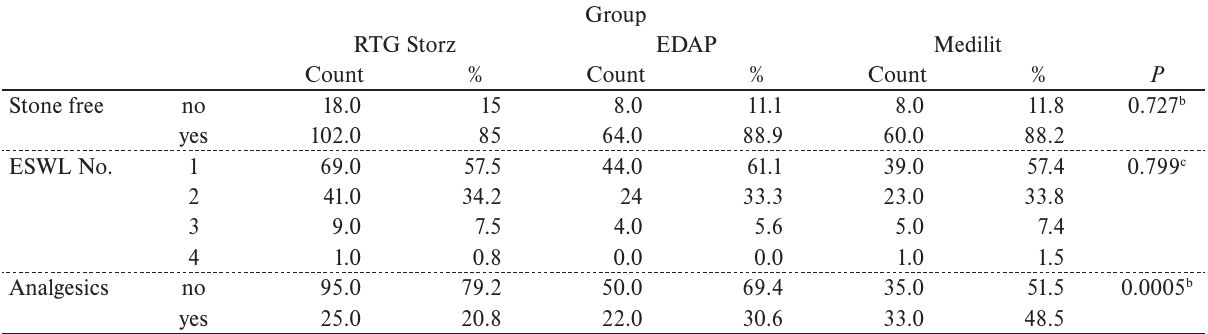
Table 4. Statistical evaluation of ESWL efficacy and rate of need for analgesics administration.